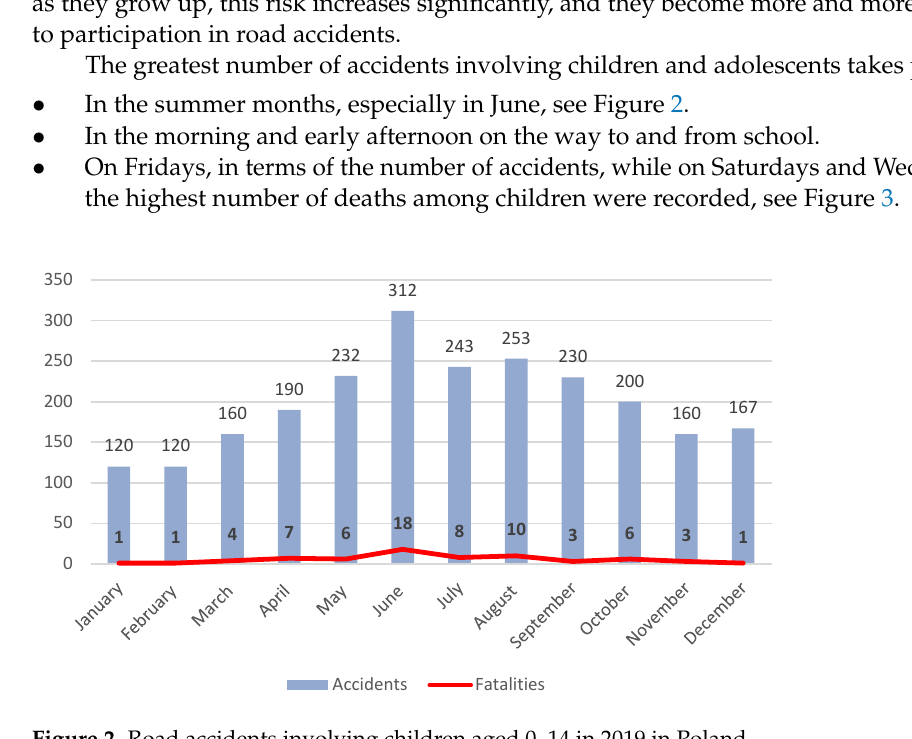
Figure 3. Road accidents involving children aged 0 – 14 by days of the week in 2019 in Poland. The vast majority of all victims among children aged 0 – 6 were vehicle passengers (as much as 80.7%), including 81.8% of fatalities. This trend is very worrying because it proves that the youngest are exposed to the risk of losing their life or health primarily due to the mistakes of adults. In the case of children from the older 7 – 14 age group, the most fatalities were among the drivers and the injured among the passengers. As shown in Figure 4, for the older age group, the level of accidents involving drivers, most often bicycles, increases.